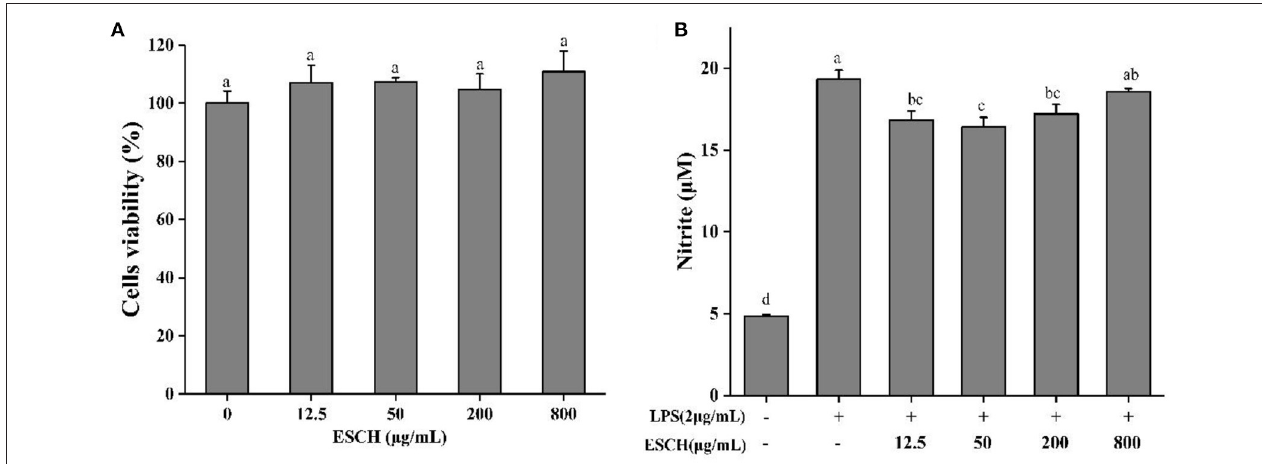
Frontiers in Nutrition |